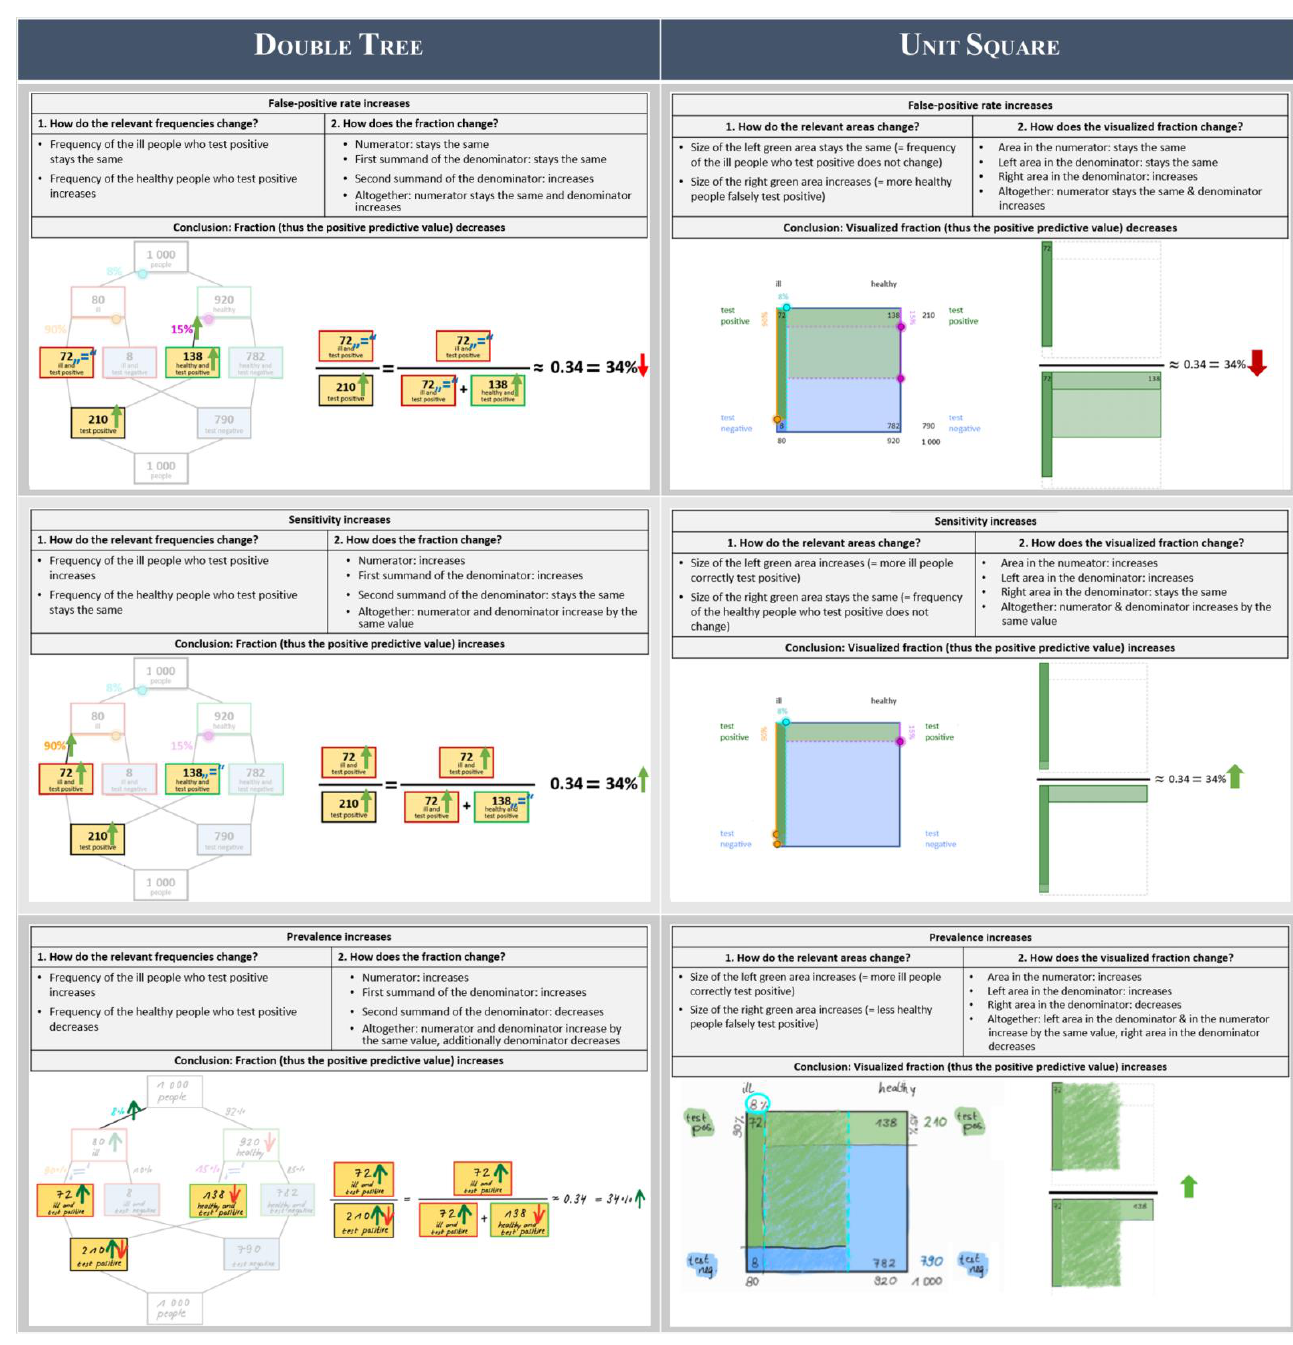
Figure 7. Screenshots from the three explanatory videos in ascending